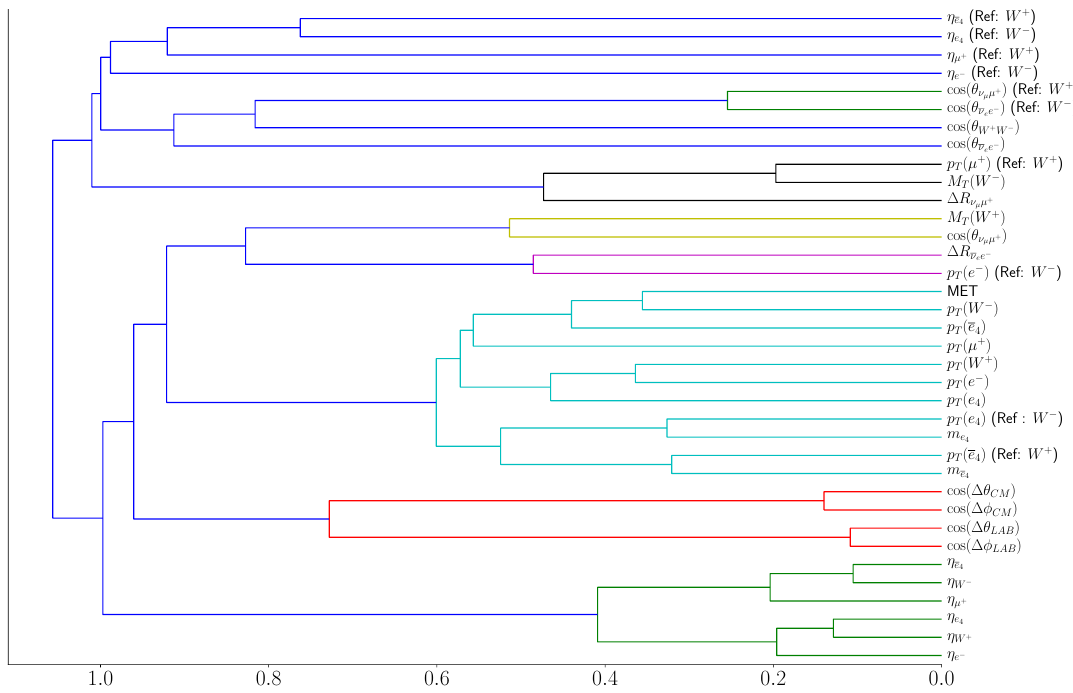
Figure 25. Hierarchical clustering of the various kinematic/angular variables utilized by the neural network model for a light VLL of 200 GeV and VBF topology signal, under the Asimov metric.